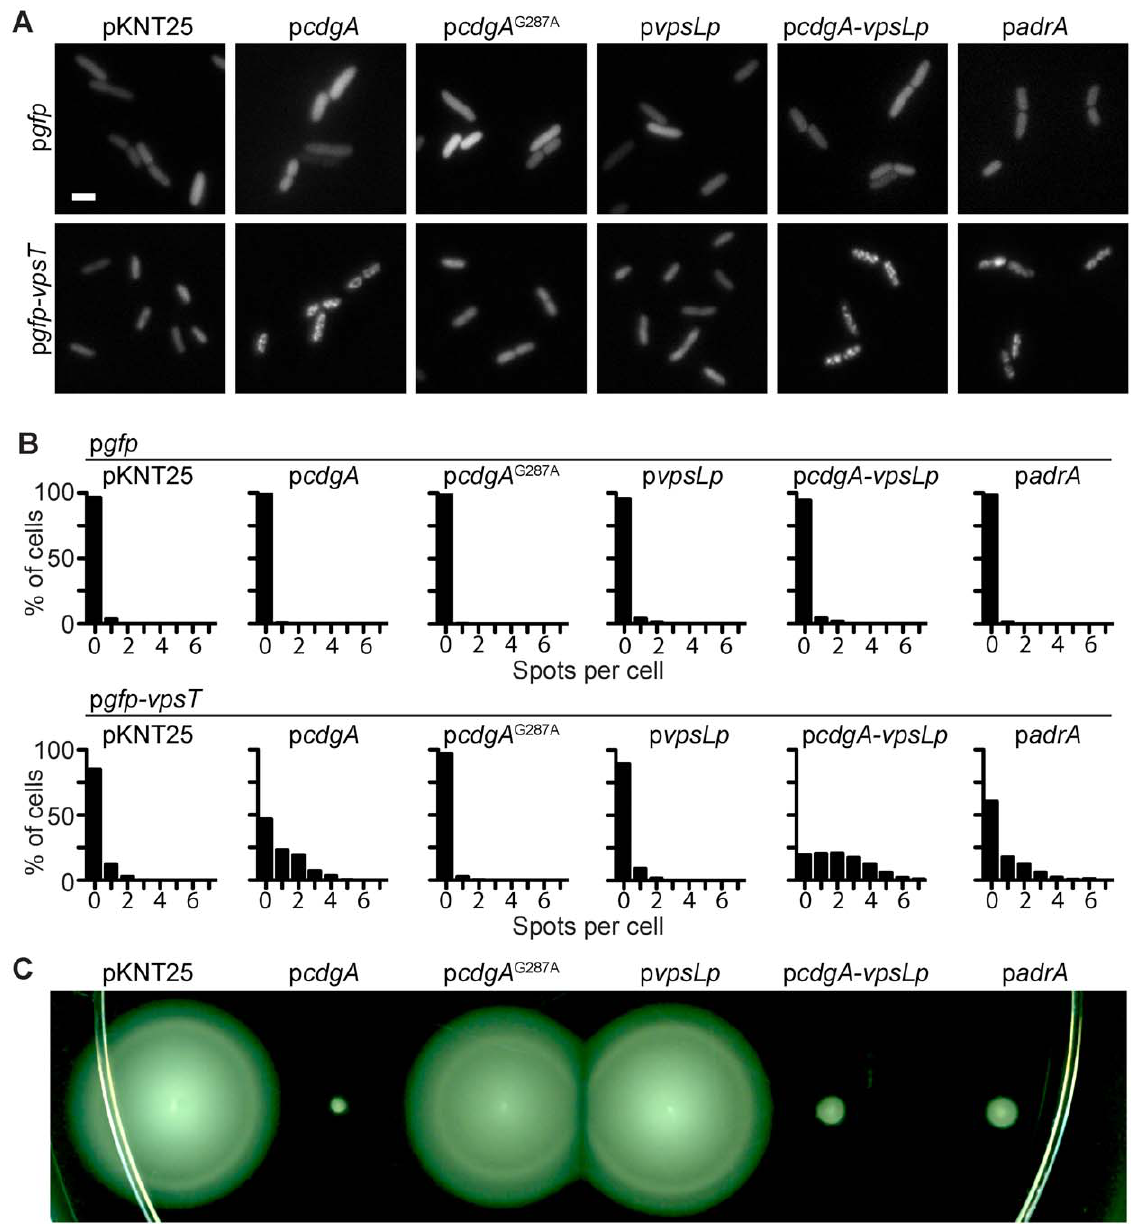
Figure 4. VpsT Localization in a Heterologous Host Depends on c-di-GMP. (A) Representative epifluorescence micrographs of E. coli strains expressing GFP or GFP-VpsT and containing a pKNT25 compatible plasmid or pKNT25 harboring cdgA , cdgA G287A , vpsL promoter ( vpsLp ), cdgA and vpsLp or adrA from S. typhimurium . Marker is 2 m m. (B) Single-cell quantification of subcellular fluorescence localization. The number of spots per cell is shown as a histogram for E. coli strains containing the indicated plasmids. Data are acquired from at least 3 independent experiments and quantification was performed on at least 150 cells per treatment. (C) Representative motility phenotypes of E. coli expressing the indicated plasmids grown on soft agar plates containing kanamycin and 10 m M IPTG at 37 u C for 12